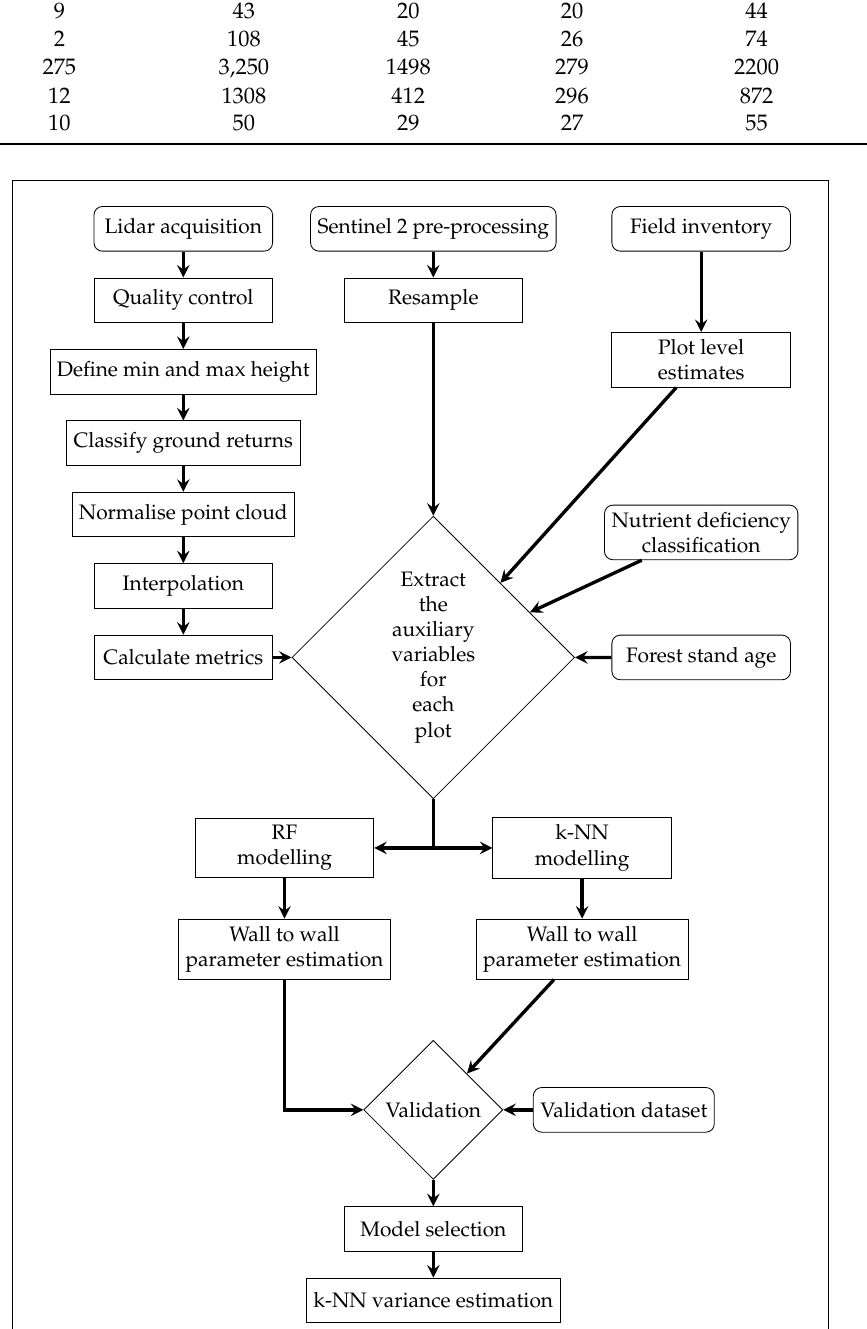
Figure 2. Methodology